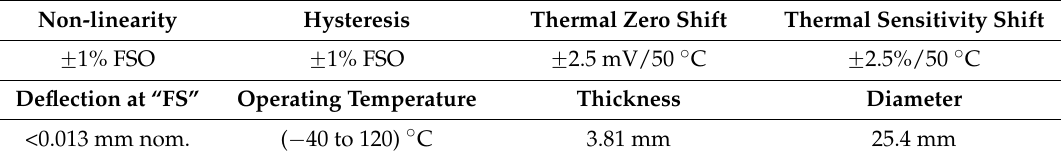
Table 2. Main technical specifications of the IMU.